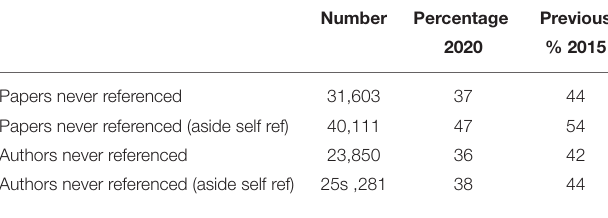
TABLE 12 | Absence of citations of authors and papers within NLP4NLP +